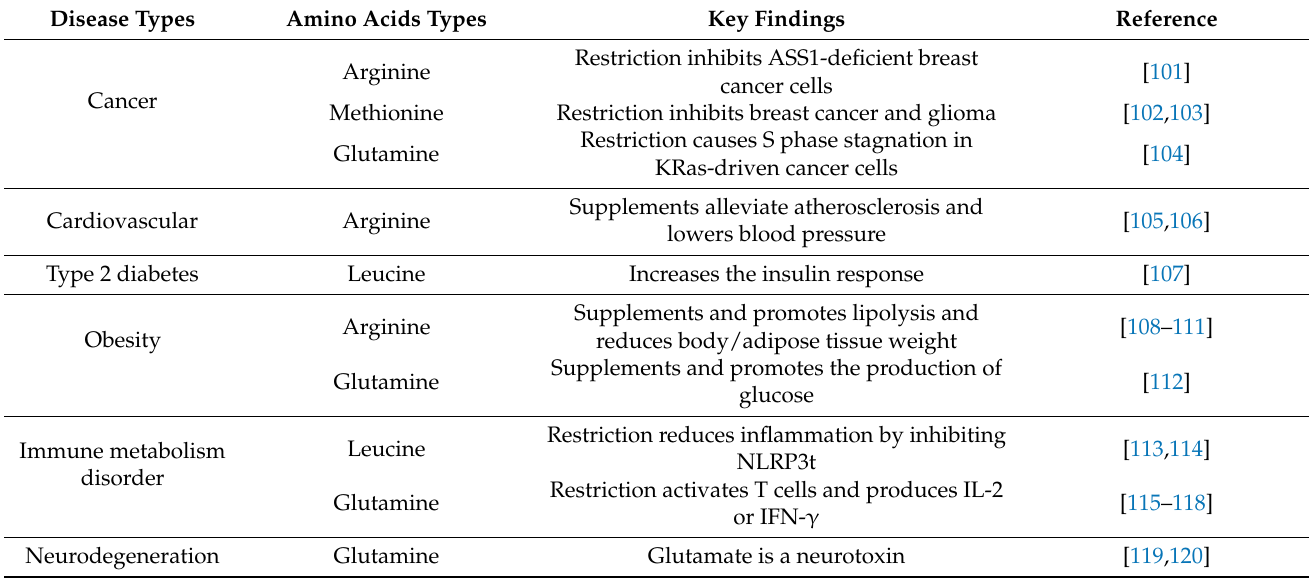
Table 1. Specific amino acids may serve as therapeutic targets for autophagy-related diseases. Disease